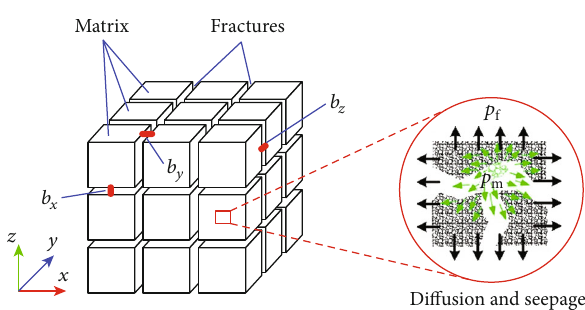
Figure 1: Methane migration modes from matrix to